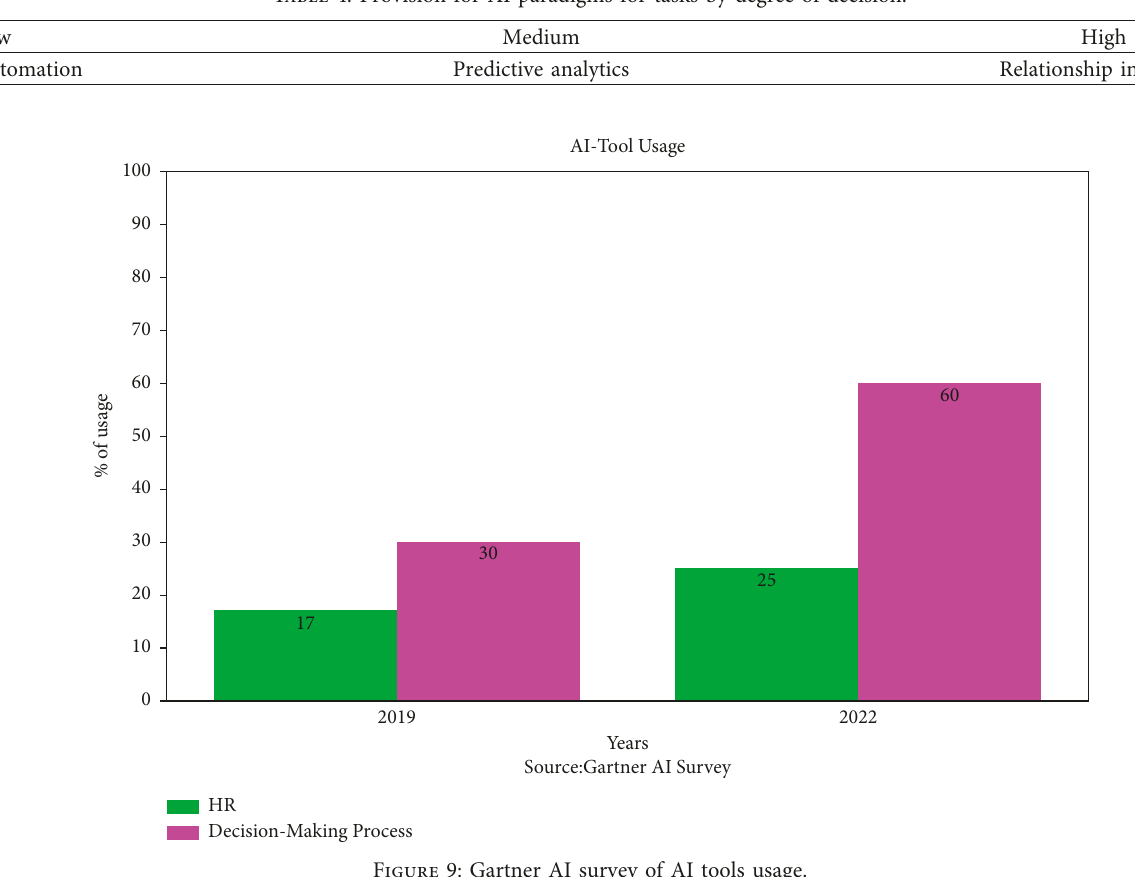
Table 4: Provision for AI paradigms for tasks by degree of decision.